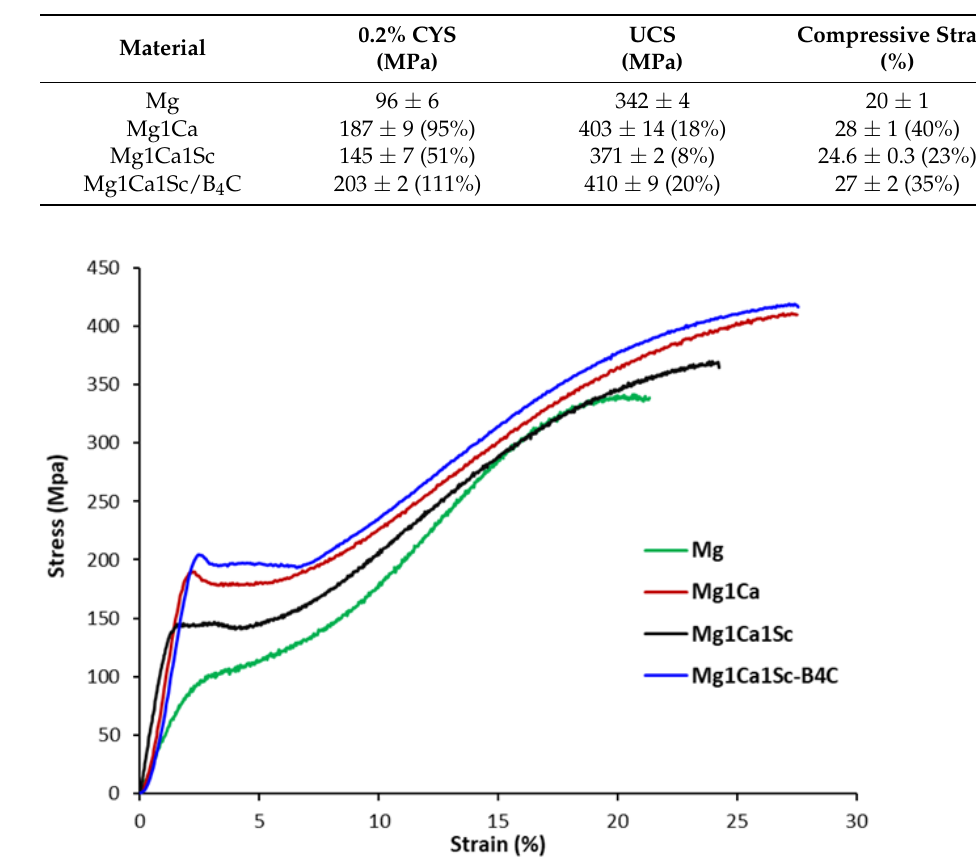
Table 1. Compressive properties of the developed Mg alloys and nanocomposite.